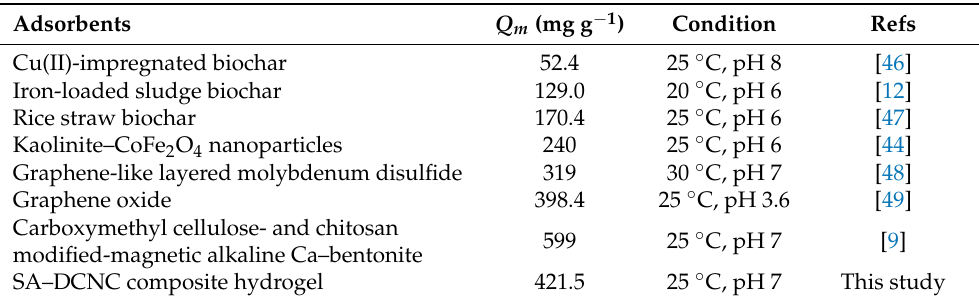
Table 5. Comparison of the maximum adsorption capacities of different adsorbents for doxycycline removal (at 25 °C).